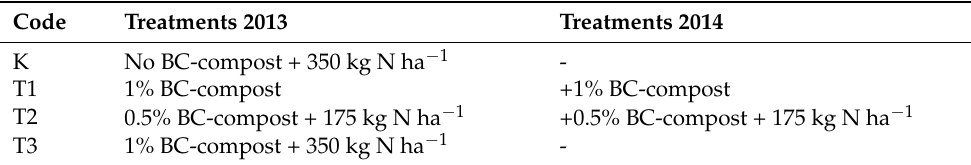
Table 1. Codes and application rates of BC-compost and mineral fertilizer in 30 April 2013 and 22 May 2014. Code Treatments 2013 Treatments